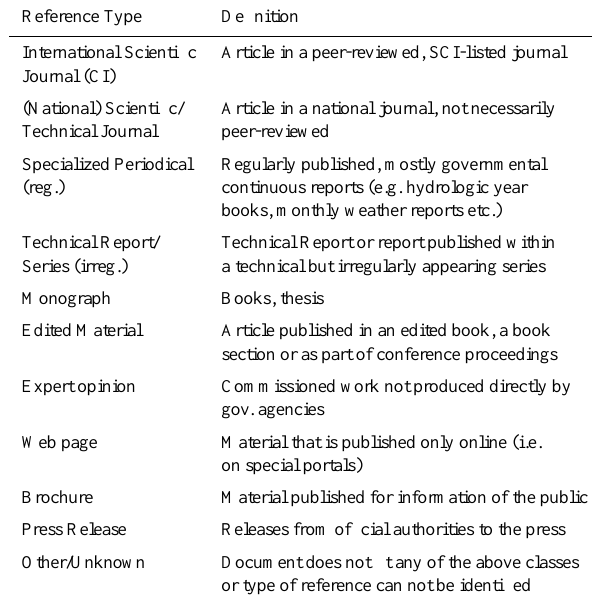
Table 2. Classification of the reference